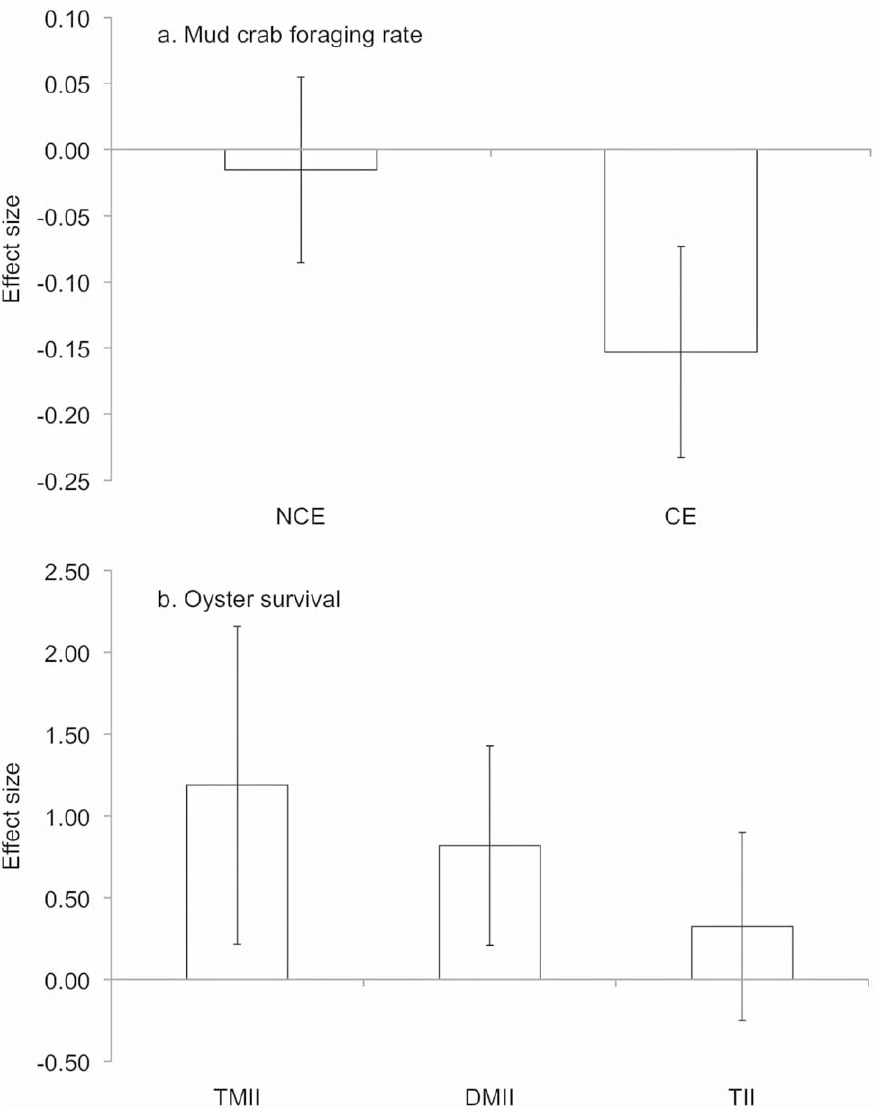
Figure 2. Direct and indirect predator effects in Experiment I. (a) The strength of non-consumptive (NCE) and consumptive (CE) effects on mud crab foraging rates in Experiment I. A negative effect size indicates that crab foraging rates were enhanced by predator cues (NCE) or crab removal (CE). Neither NCEs nor CEs varied by culling treatment (high cull or low cull). Bars represent means( 6 SE). (b) The strength of trait-mediated indirect interactions (TMII), density-mediated indirect interactions (DMII) and total indirect predator interactions (TII) on oyster abundance in Experiment I. A positive effect size indicates that oyster abundance was enhanced by predator cues (TMII), culling (DMII), or the combination of high culling and predator cues (TII). DMIIs did not vary by culling treatment (high cull or low cull). Bars represent means( 6